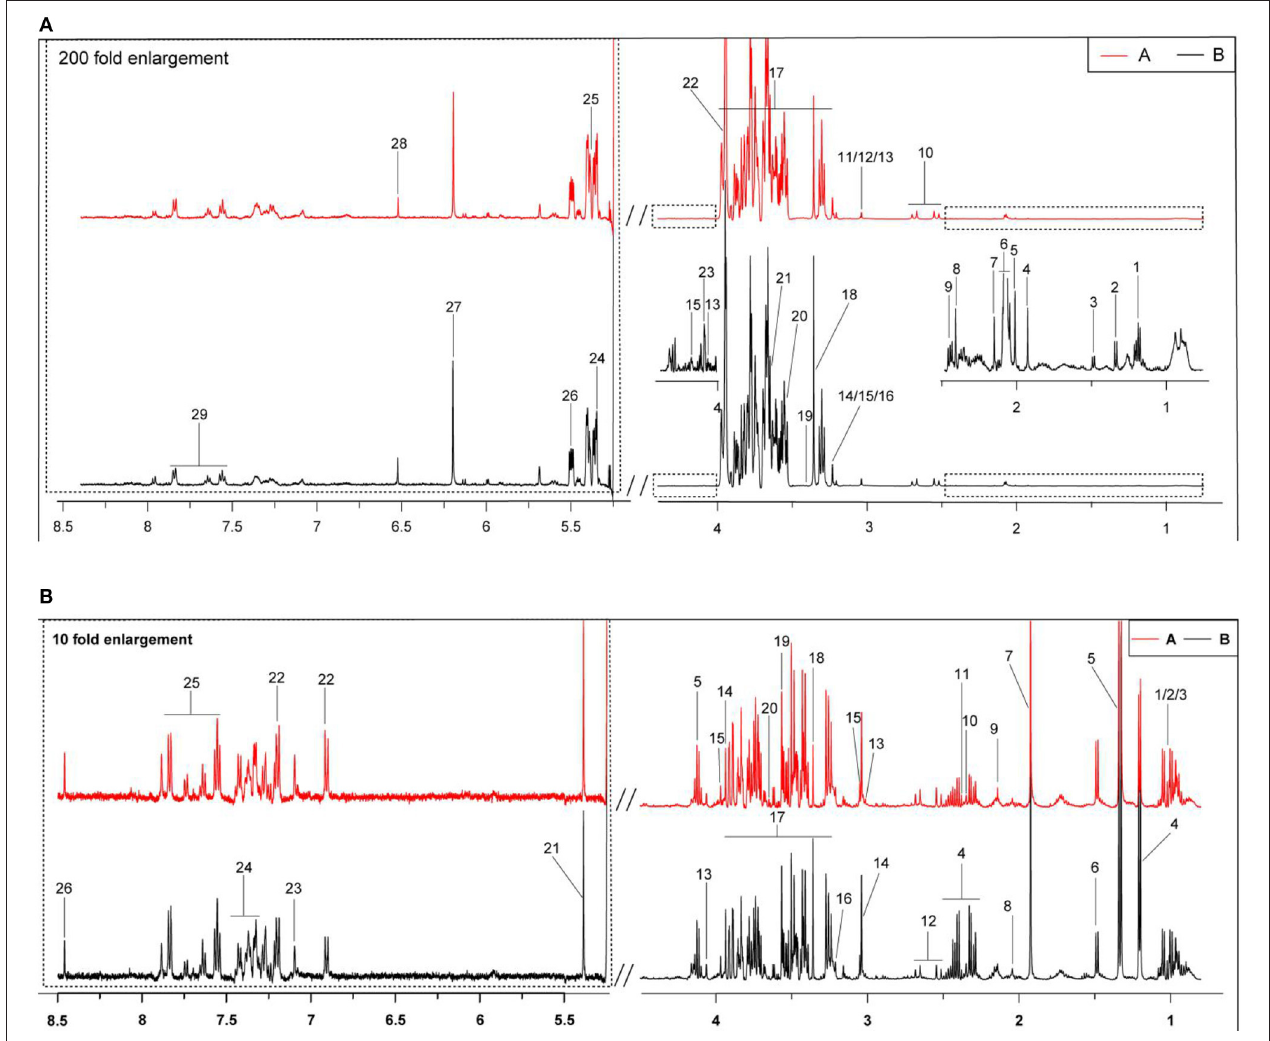
FIGURE 1 | Typical 1 H-NMR spectra (500Hz) of milk whey and serum from groups A and B. (A) Estrus group ( ); (B) inactive ovaries group ( ). (A) The typical 1 H-NMR spectra of milk whey. 1, 3-hydroxybutyrate; 2, lactate; 3, alanine; 4, acetate; 5, acetamide; 6, N-acetyl carbohydrates; 7, acetylcholine; 8: succinate;